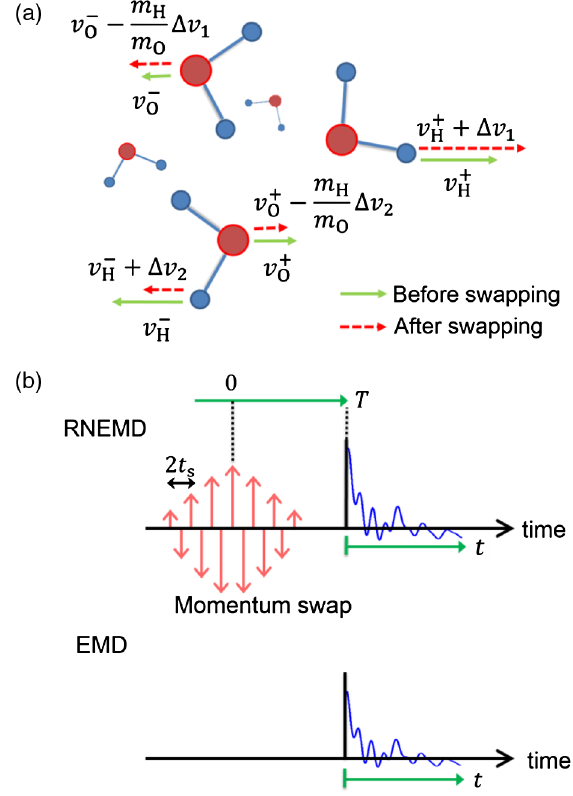
FIG. 4. Representation of the computational method. Sche- matic pictures of (a) swapping partial atom velocities in H 2 O and (b) simulation procedures to calculate the VCFs from the RNEMD and EMD